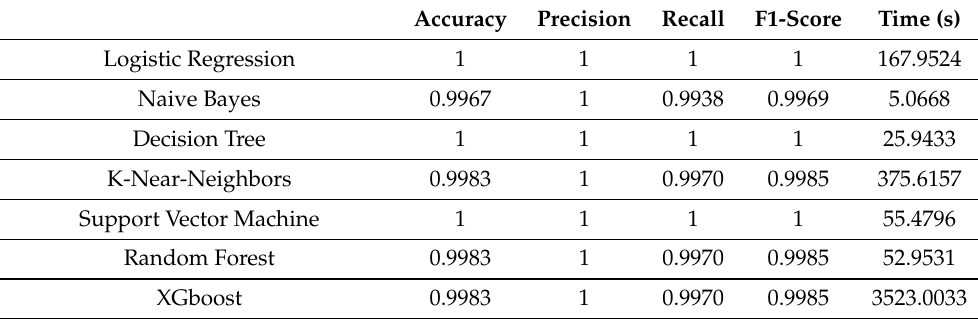
Table 2. Detection performance of identifying different attacks target an SH control platform scenario.